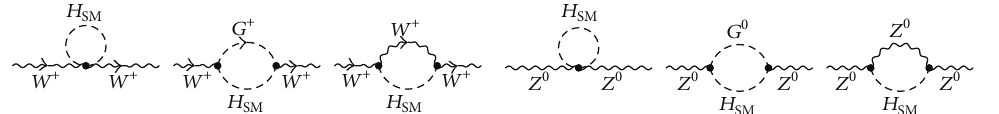
Figure2:(a):Obliqueparameters 𝑆 and 𝑇 intheNMSSMintheconstrainedcasewithcentralparameterstan (𝛽) = 1.7 , 𝑀 0 = 𝑀 1/2 = 500 GeV, = −800 GeV, 𝐴 = −1500 GeV, sgn (𝜇) = + , and 𝜆 = 0.5 (second row in Table 1) with successive variations of the parameters 𝑀 𝐴 0 𝜅 = 450 GeV, 500 GeV, . . . ,650 GeV, 𝐴 = −800 GeV, − 700 GeV, . . . , − 100GeV, as indicated in the figure. (b): 250 GeV, 300GeV, . . . ,500GeV, 𝑀 1/2 0 Same as (a) but with central parameters tan (𝛽) = 5 , 𝑀 0 = 100 GeV, 𝑀 1/2 = 200 GeV, 𝐴 0 = −700 GeV, 𝐴 𝜅 = −75 GeV, sgn (𝜇) = + , and 𝜆 = 0.2 with successive variations of the parameters tan (𝛽) = 2, 3,. .. ,15 , 𝑀 0 = 0 GeV, 100GeV, . . . ,800 GeV, 𝑀 1/2 = 200 GeV, 225 GeV, . . . ,400GeV.